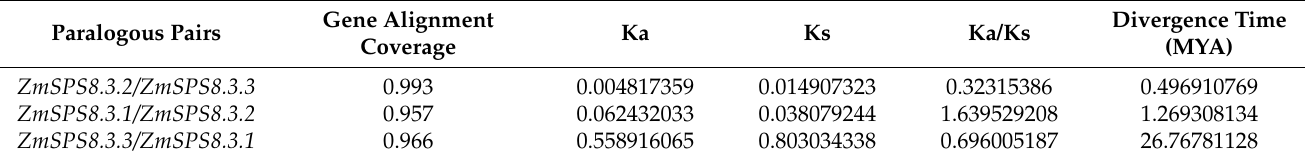
Figure 2. Chromosomal distribution and segmental duplication events of serine peptidase S8 family genes in maize. The duplicated paralogous pairs of family genes were connected with red dashed lines. Chromosome numbers were located under each vertical bar. Gene IDs in black represent maize serine peptidase S8 family genes. Table 2. Inference of duplication time in paralogous pairs.